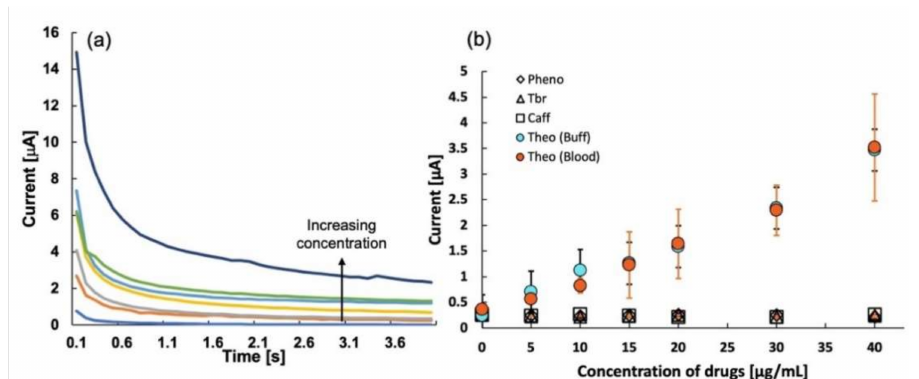
Figure 7. ( a ) Chronoamperometry graph for theophylline sensor, and ( b ) calibration curve for sensitivity of theophylline in buffer and in whole bovine blood. The graph also shows the selec- tivity of theophylline sensor over theobromine, caffeine, and phenobarbital as obtained from the chronoamperometric